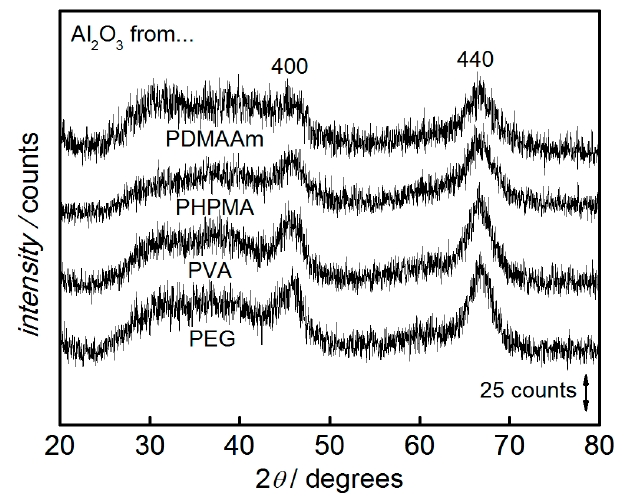
Figure 4. Powder XRD patterns of mesoporous γ -Al 2 O 3 prepared using various polymers as the porogenic structure matrices as indicated. (Data are vertically shifted for clarity).